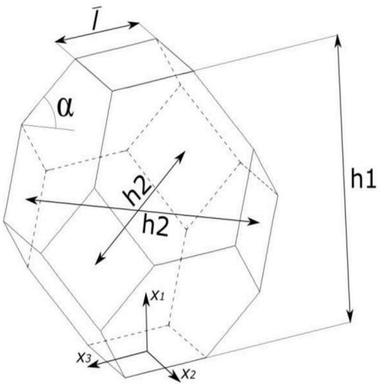
Regular 14-sided polyhedron of Kelvin cell.